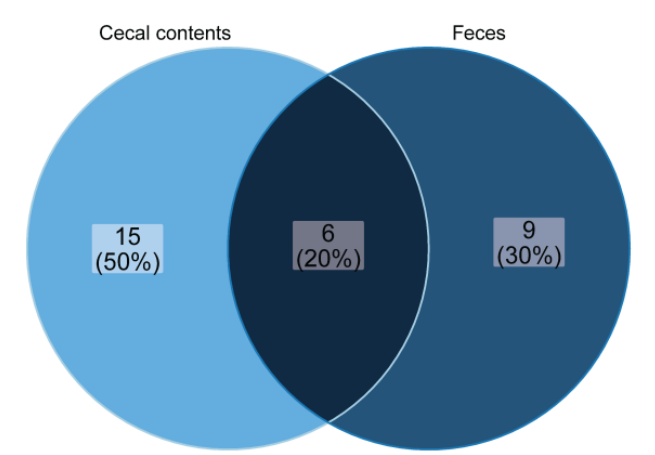
Figure 5. Venn diagram showing significantly different OTUs (selected with a criterion of FDR- adjusted P -values <0.05 and absolute log2-fold change > ± 1) between pigs fed different diets that are shared in cecal contents and feces.